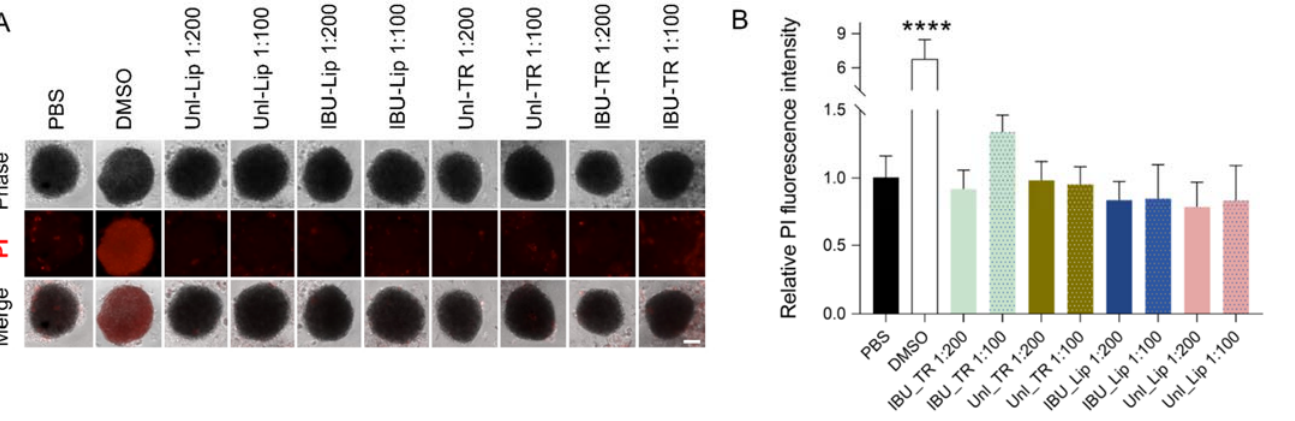
Figure 3. Unloaded and IBU-loaded transfersomes (Unl-TR and IBU-TR, respectively) and liposomes (Unl-Lip and IBU-Lip, respectively) did not induce cell death of 3D HaCaT cell cultures. ( A ) Representative images of 3D HaCaT cultures incubated for 24 h with the indicated transfersomes and liposomes, vehicle (PBS), or a cell death inducer (10% DMSO). ( B ) The summarized results of cell viability studies are shown as mean relative fluorescence intensity ± SD from three independent experiments. **** p < 0.0001 compared with vehicle-treated cells (two-way ANOVA, Tukey’s multiple comparison test). Scale bar 100 µm.